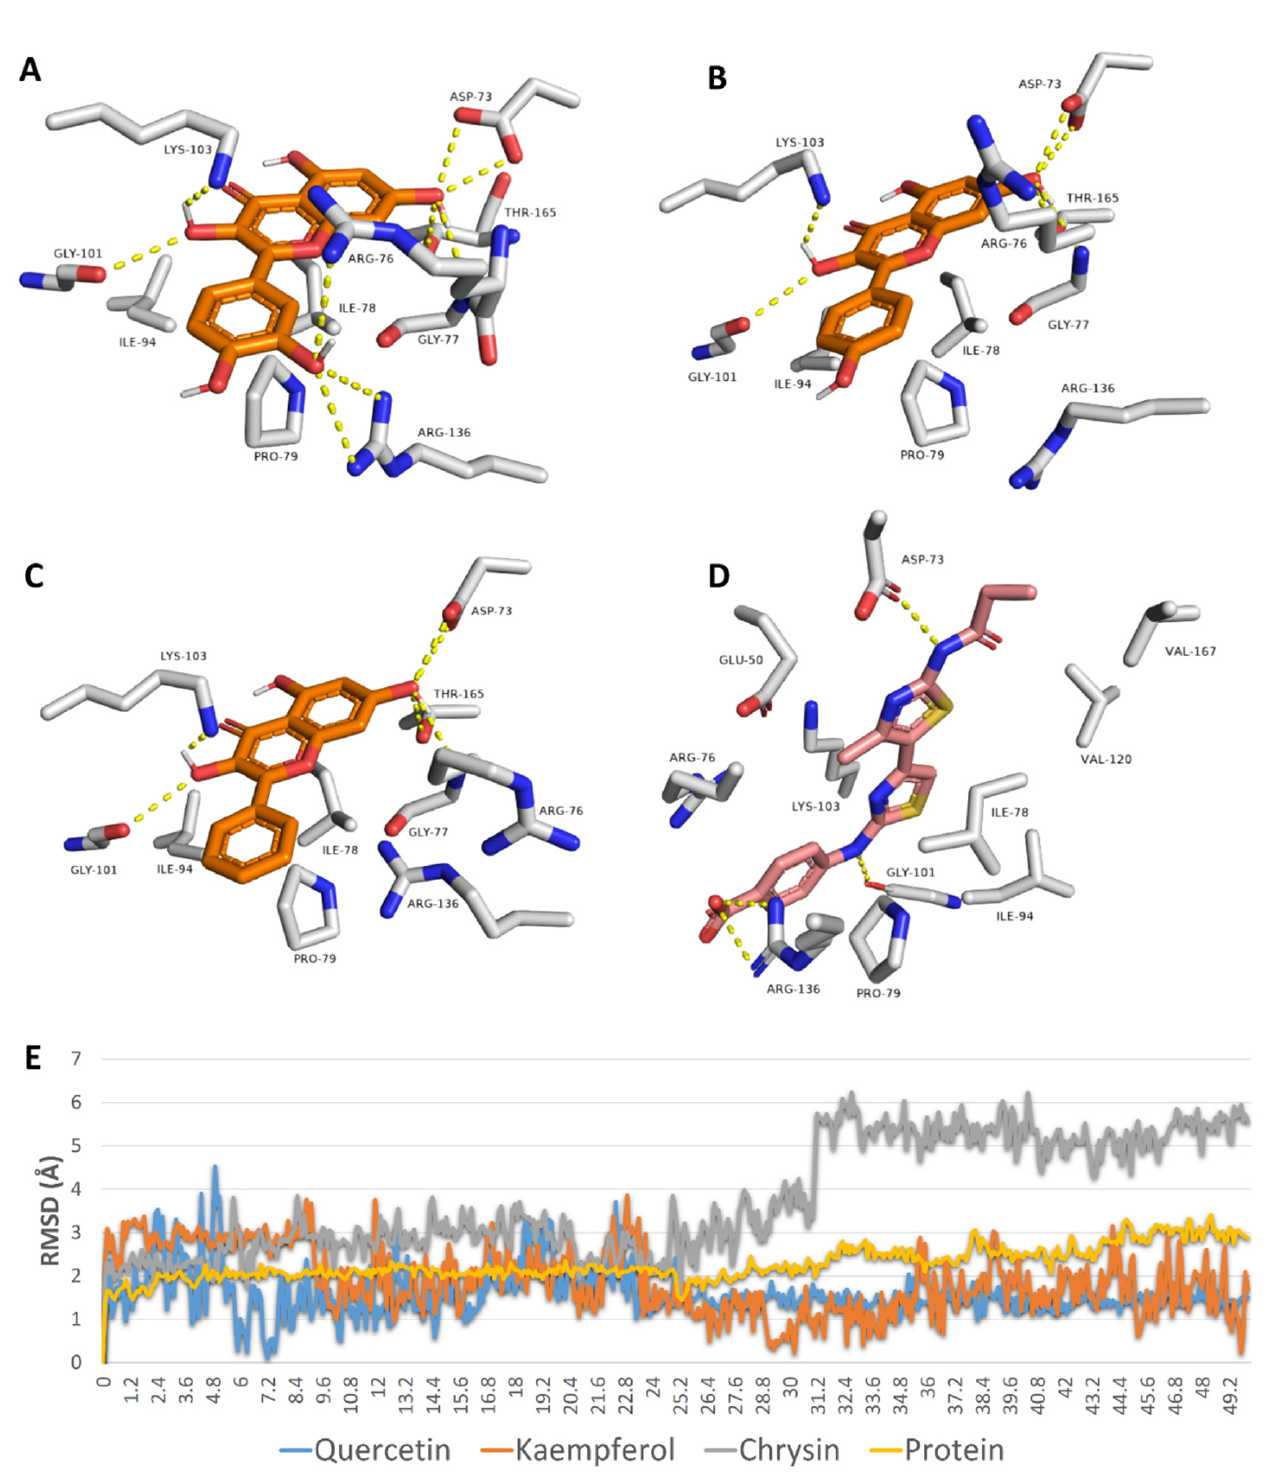
Figure 9. Docking poses of quercetin, kaempferol, and chrysin inside the active site of E. coli ’s Gyr-B ( A – C , respectively) alongside the binding pose of the co-crystalized inhibitor ( D ). RMSDs of quercetin, kaempferol, and chrysin inside the active site of E. coli ’s Gyr-B during 50 ns of MDS ( E ).